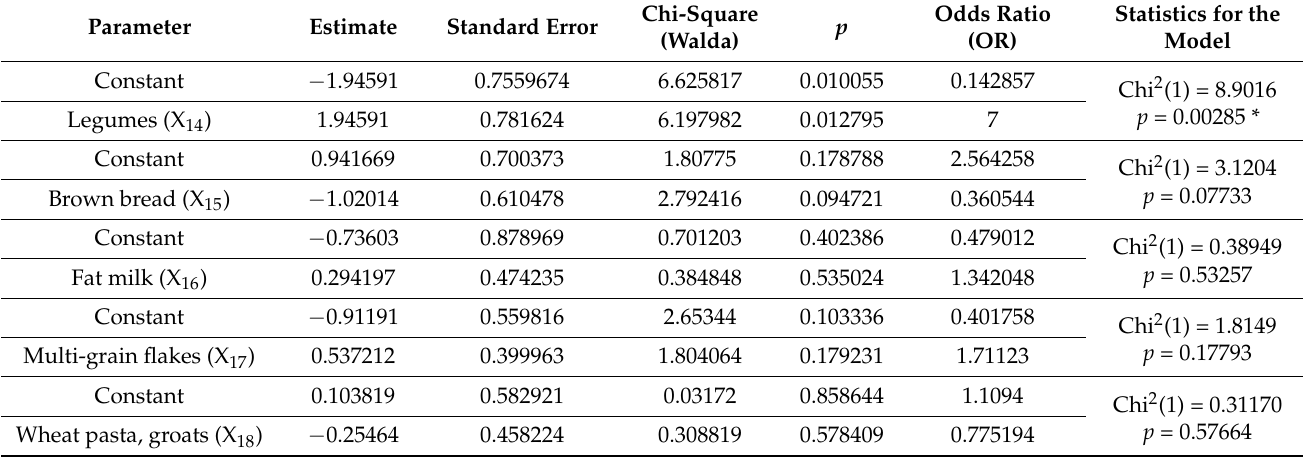
Table 14. Logistic regression results (LRS)—assessment of the relationship between selected food products considered individually and the probability of an increased level of homocysteine for the SDA group. Parameter Estimate Standard Error